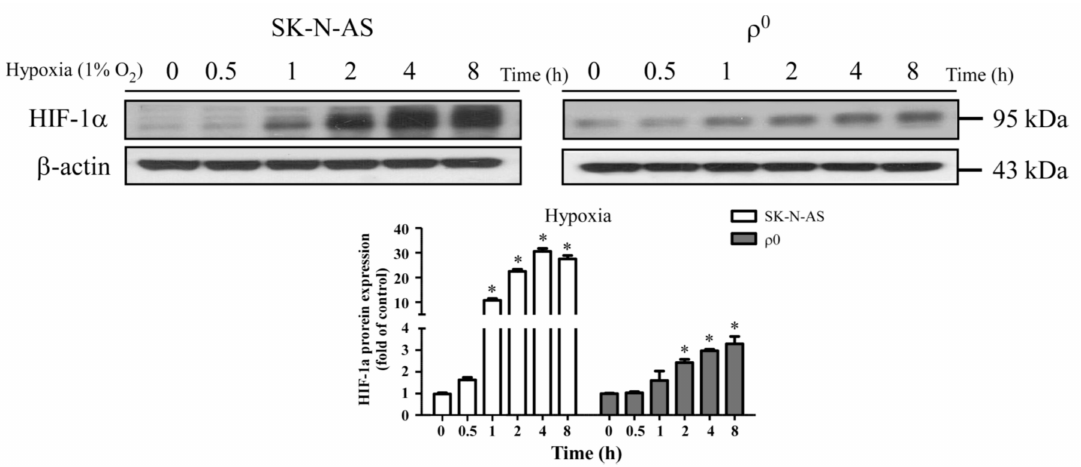
Figure 1. Hypoxia induced factor 1 α (HIF-1 α ) was activated in hypoxic SK-N-AS and (cid:36) 0 cells. The upper panel shows HIF-1 α protein expression with immunoblotting after different hypoxic times in SK-N-AS and (cid:36) 0 cells; the bar chart below illustrates HIF-1 α protein expression change with different hypoxic times (relative quantification to β -actin). Data are shown as mean ± SD of three independent experiments. * Represented p < 0.05 when compared to normoxic condition was determined using one-way